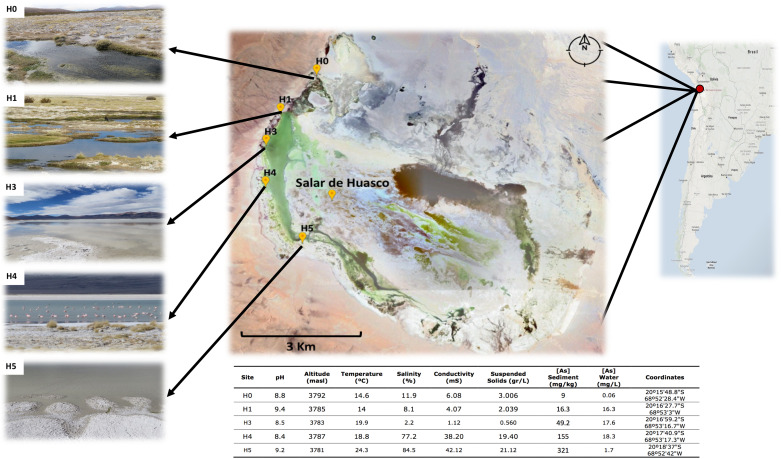
Salar de Huasco sampling sites and characteristics. Above: Salar de Huasco localization and map indicating the five sampled sites from which the studied strains were isolated. Source: Google-Earth. Below: table of the five sites environmental and physicochemical measured characteristics.